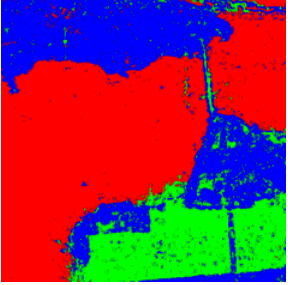
Figure 14. Classification results of the whole